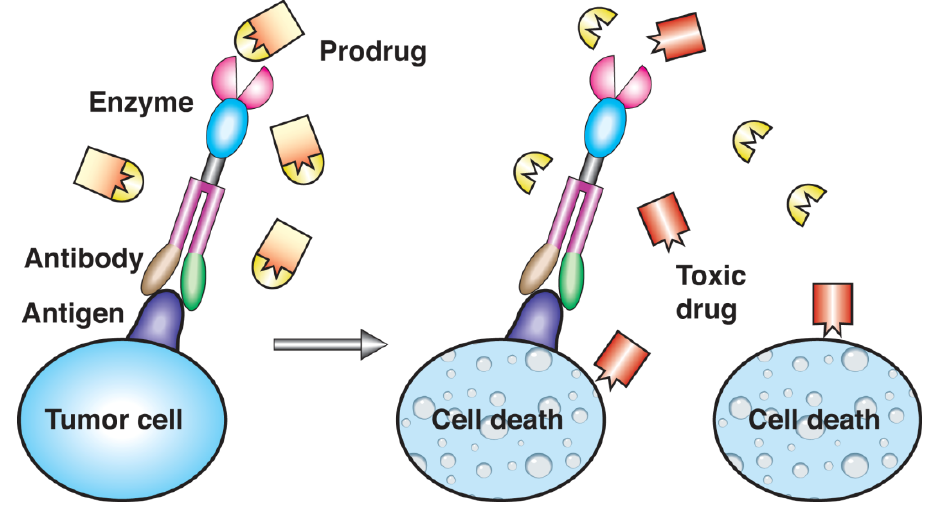
Figure 6. Schematic diagram of the principle of ADEPT. An antibody-enzyme fusion protein, injected i.v., is allowed to localize to tumors. After enzyme activity is cleared from circulation, a prodrug remains and the enzyme cleaves the prodrug to release the active drug. The extracellularly generated drug can diffuse throughout the tumor and kill antigen positive tumor cells as well as tumor cells not expressing the relevant antigen, thus giving a ‘‘bystander’’ effect. Adapted from ref.